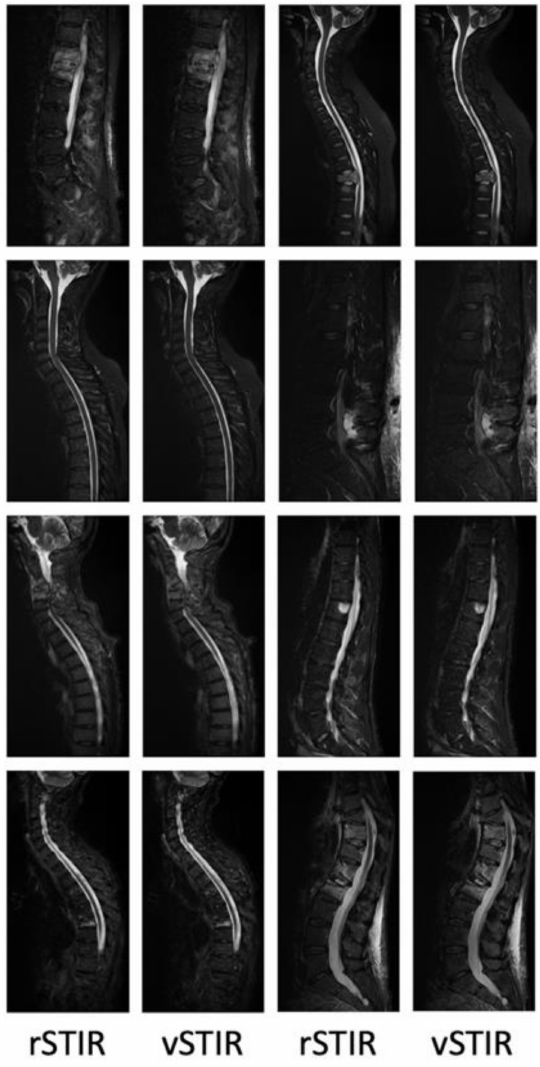
Figure 3. Examples of the validation